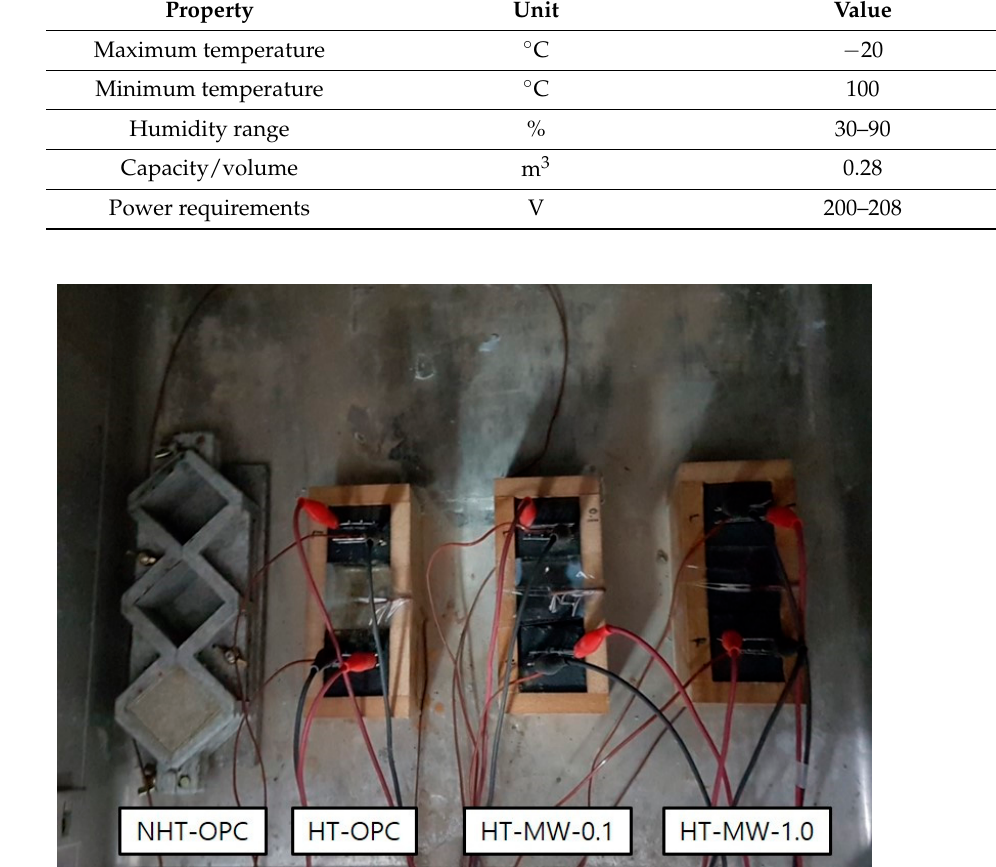
Figure 4. Setup of the heat curing